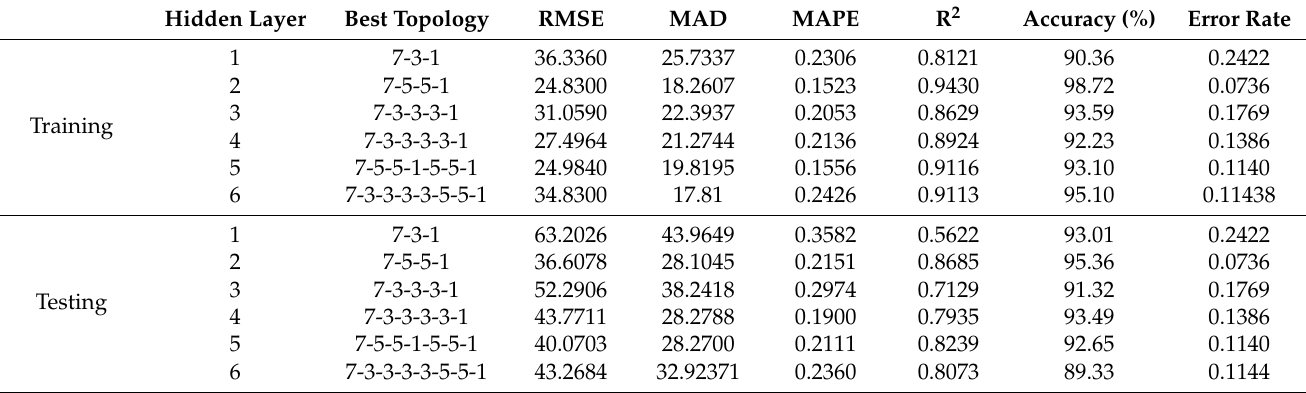
Table 3. The performance of ANN models with different hidden layers in the training and testing